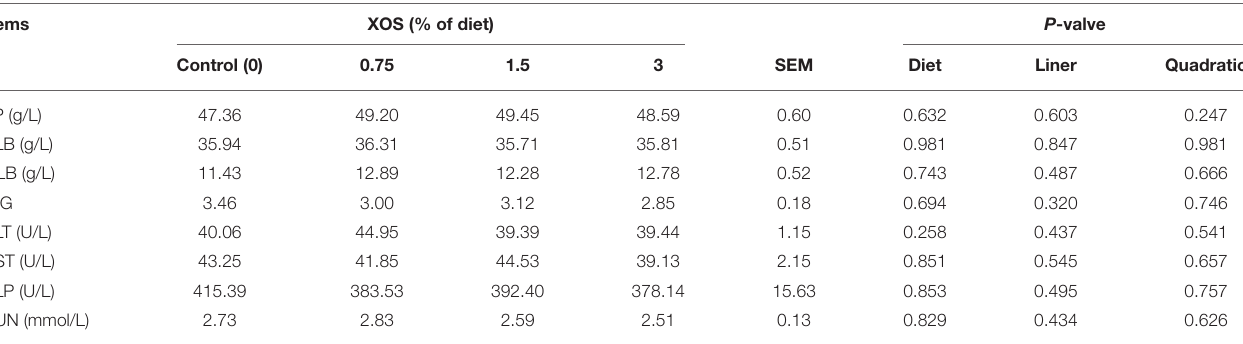
TABLE 4 | The effects of XOS supplementation on serum biochemical parameters of weaning piglets.